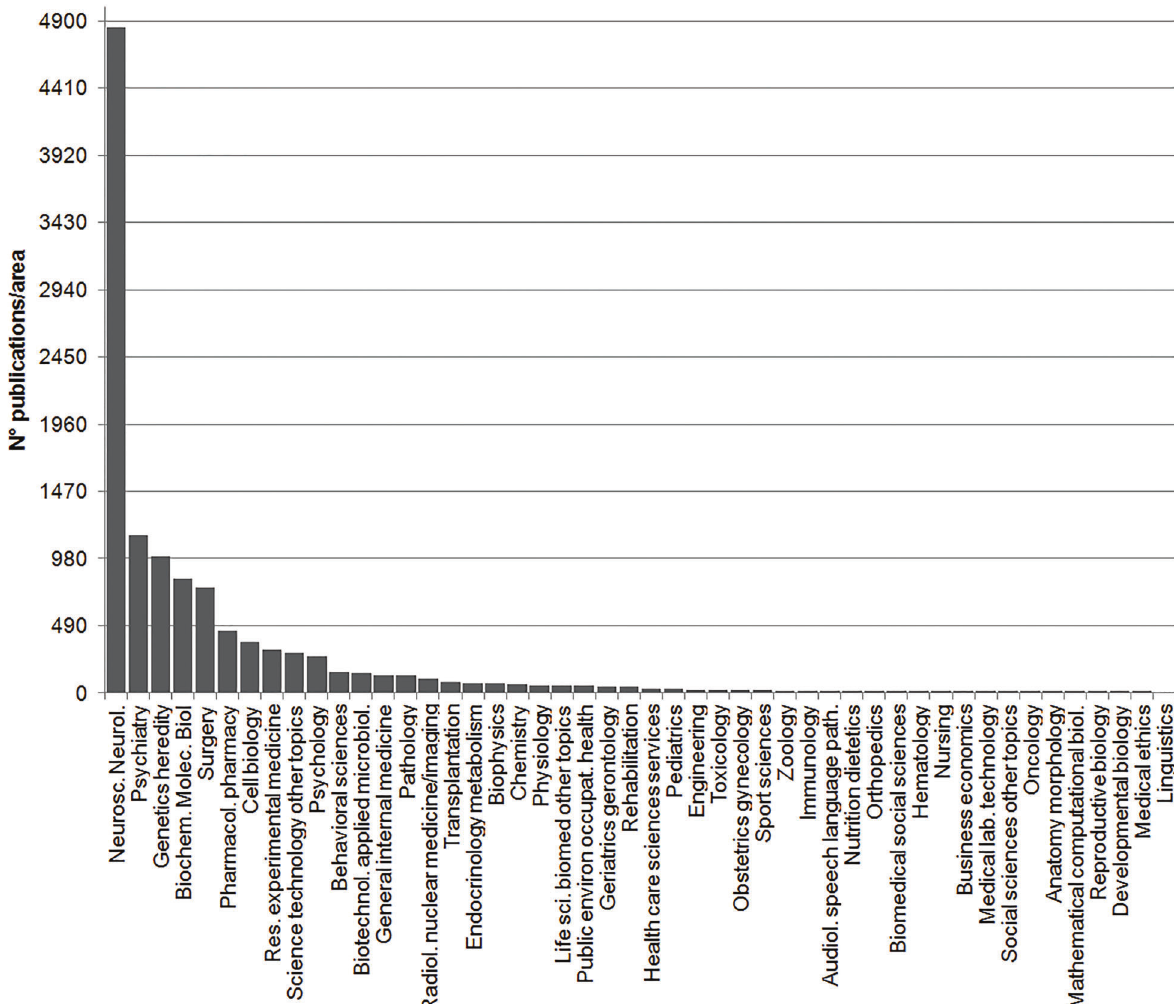
Figure 4. Number of publications classi fi ed by areas of knowledge. Areas have been abbreviated according to International Index